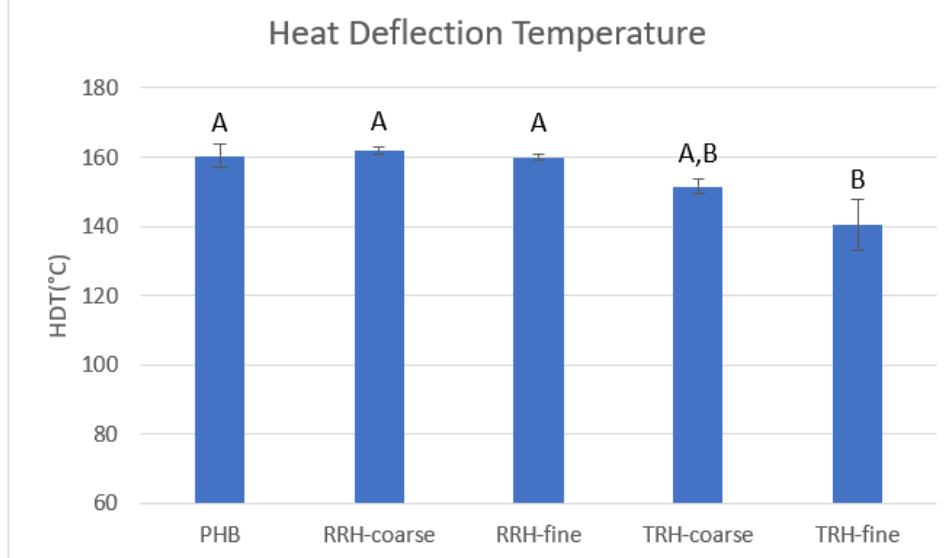
Figure 11. Heat deflection temperatures measured using TMA for PHB and PHB composites. Stand- ard deviation of measurements listed in parentheses. Means with same letter are not significantly different by Tukey’s test ( α = 0.05).